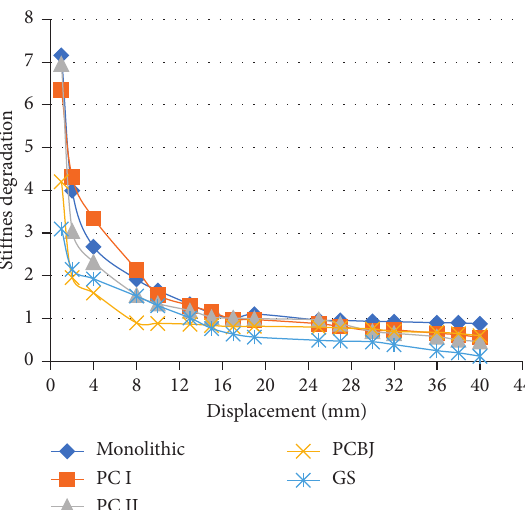
Figure 18: Stiffness degradation of all